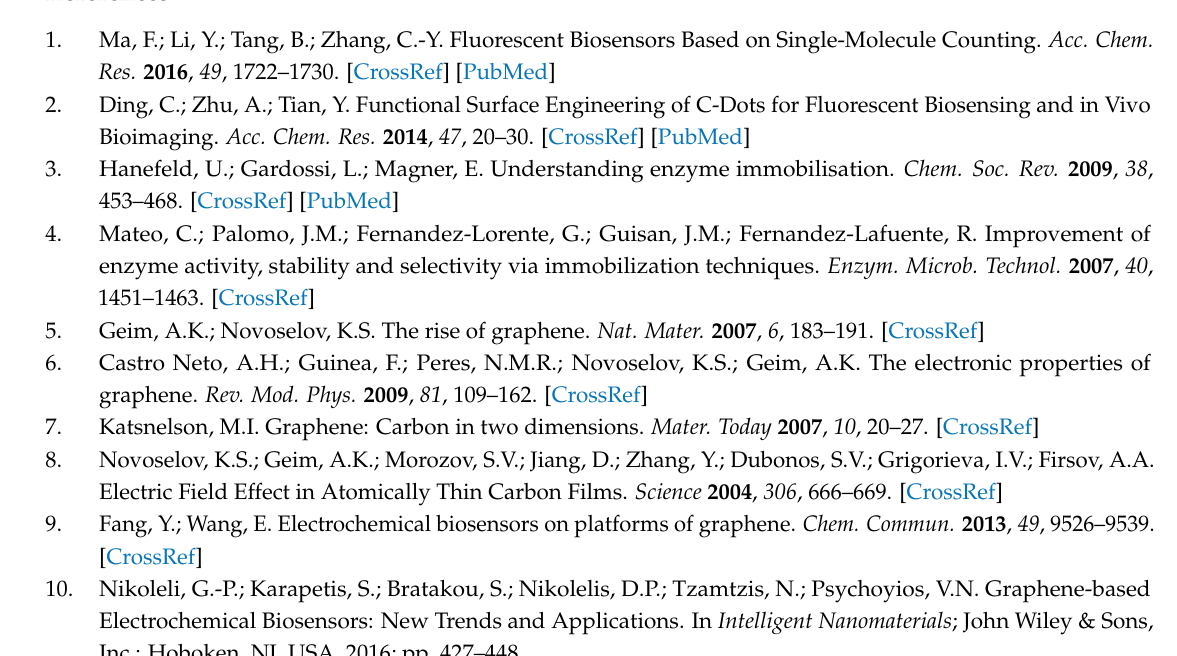
Figure S1: SEM images representing (a) top view of pDAN modified CVD graphene and the cross-sectional images of CVD graphene electrodes modified with (b) 25 cycles; (c) 50 cycles and (d) 75 cycles, Figure S2: Electrochemical Impedance spectrum of CVD graphene and CVD graphene modified with 25 cycles of pDAN